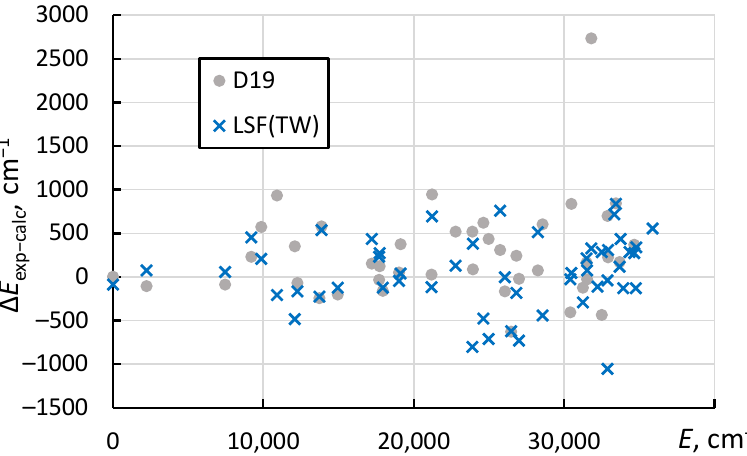
Figure 4. Differences of energy levels calculated by Dzuba et al. [3] (D19) and in the present LSF calculation (TW) from experimental